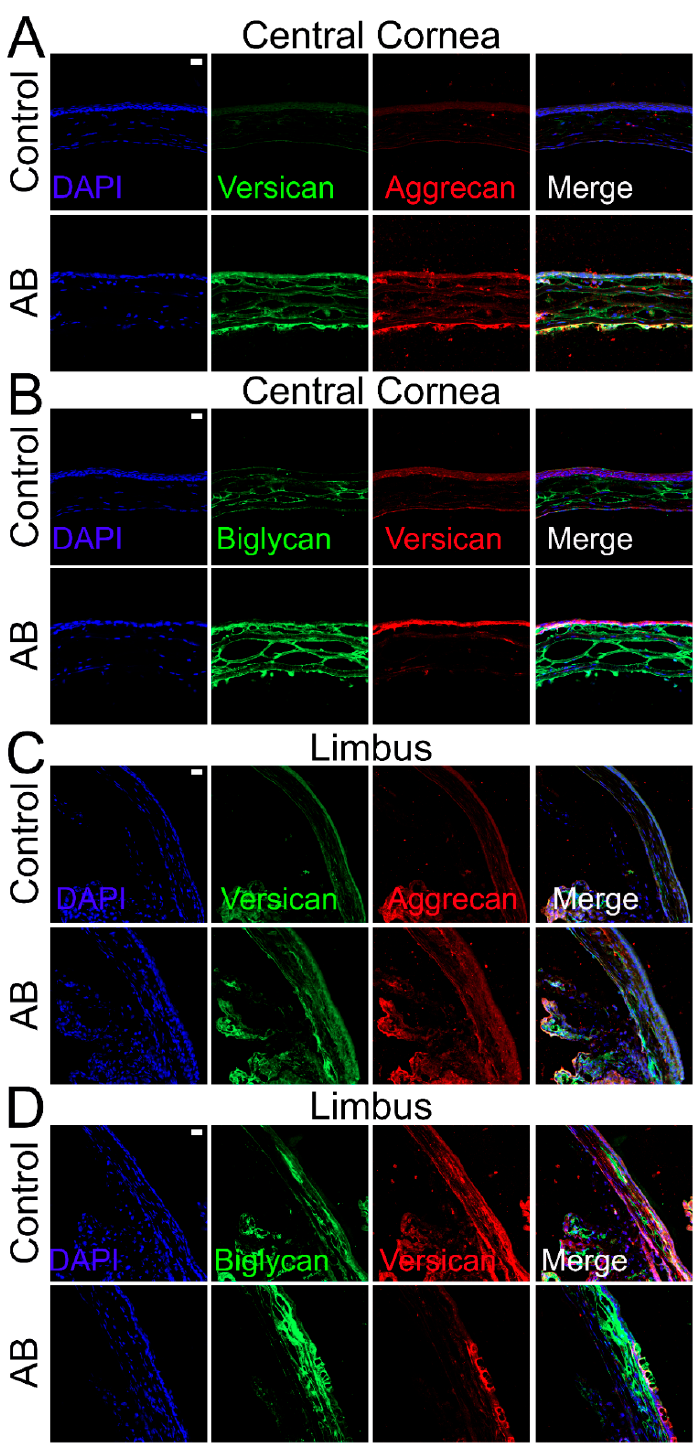
Figure 6. Expression and localization of versican, aggrecan and biglycan in the central corneal and limbal region of mice before and after AB. Mouse corneas were subjected to AB and corneas analyzed after 14 days, with contralateral corneas used as controls. The central cornea ( A , B ) and the limbal region ( C , D ) were imaged under a confocal microscope. The expression and localization of versican and aggrecan ( A , C ), and, biglycan and versican ( B , D ) were analyzed using immunocyto- chemistry. Nuclei were stained with DAPI (blue). Scale bar 20 μ m. Seven corneas were analyzed per experimental group and a representative image displayed.